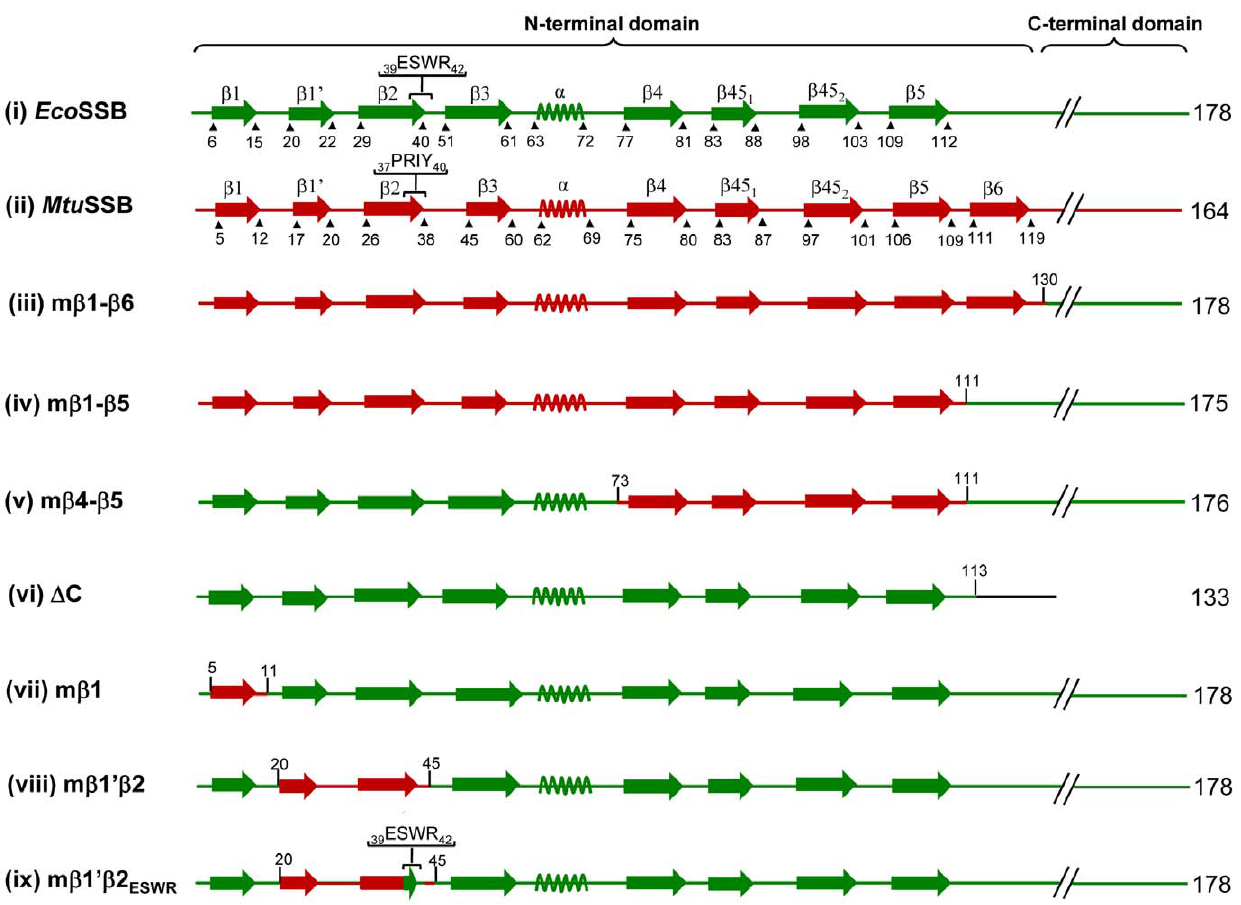
Figure 2. Schematic representation of the secondary structure elements. Mtu SSB and Eco SSB are represented in red and green colors, respectively. The beginning and end of each structural unit are numbered. The C-terminal domains are shown by discontinuous lines. In the chimeric proteins, various structural elements (N-terminal domain) are indicated in the respective colors.